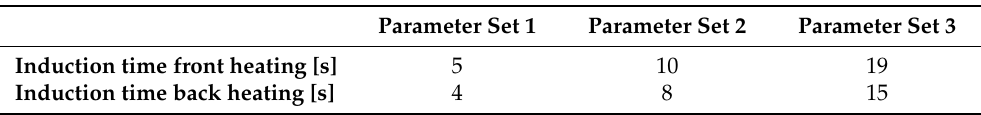
Figure 3. Schematic overview of the measurement setup used for induction thermography mea- surements. Both front and back heating are performed. The parameter values can be found in Table 4. Table 3. Parameters used during inductive thermography of spot welds. Each sample of the A-series is inspected using these